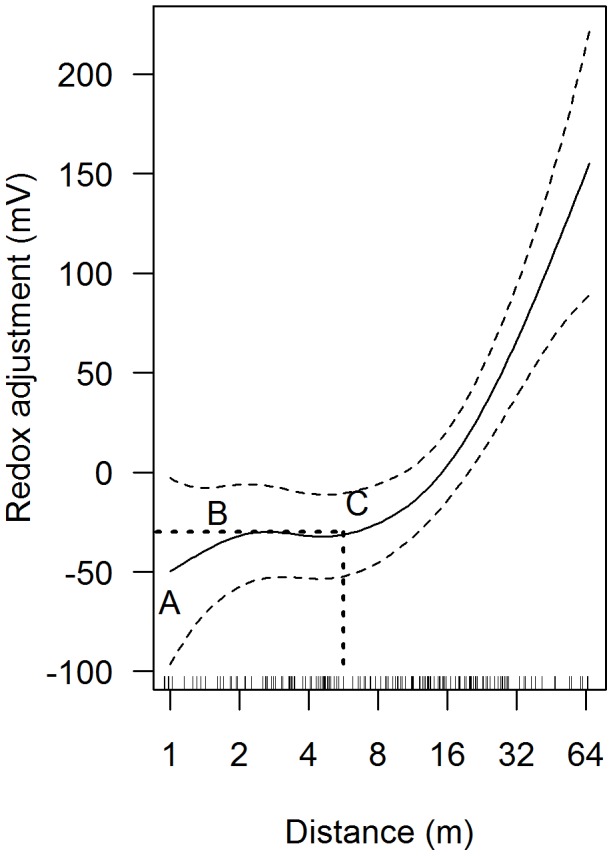
GAMM modelled relationship between Log2Dist (m) and redox.The predicted redox, at any distance, should be read off the Y axis and then added to the model intercept estimate given in Table 2 (e.g. at a distance of ∼6 m the model predicts a redox of the model intercept minus 30 = 88 mV). The rug (jittered) on the X axis indicates distances where sampling occurred (N = 159). The regions A to B, B to C and C onwards are explained in the text.